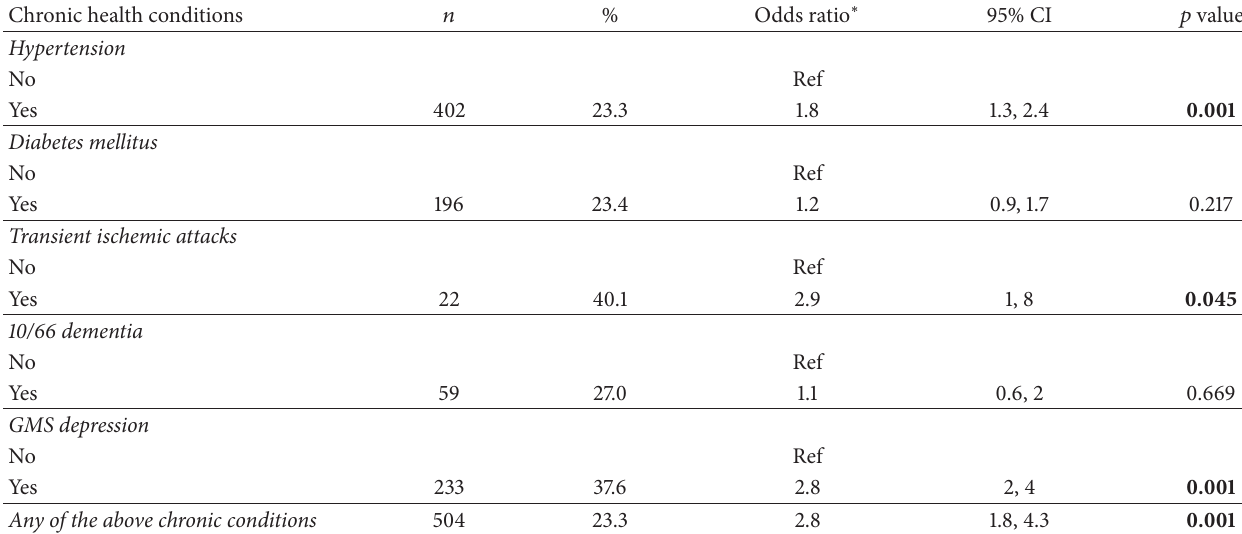
Table 2: Relationship between overall pain and chronic health conditions.